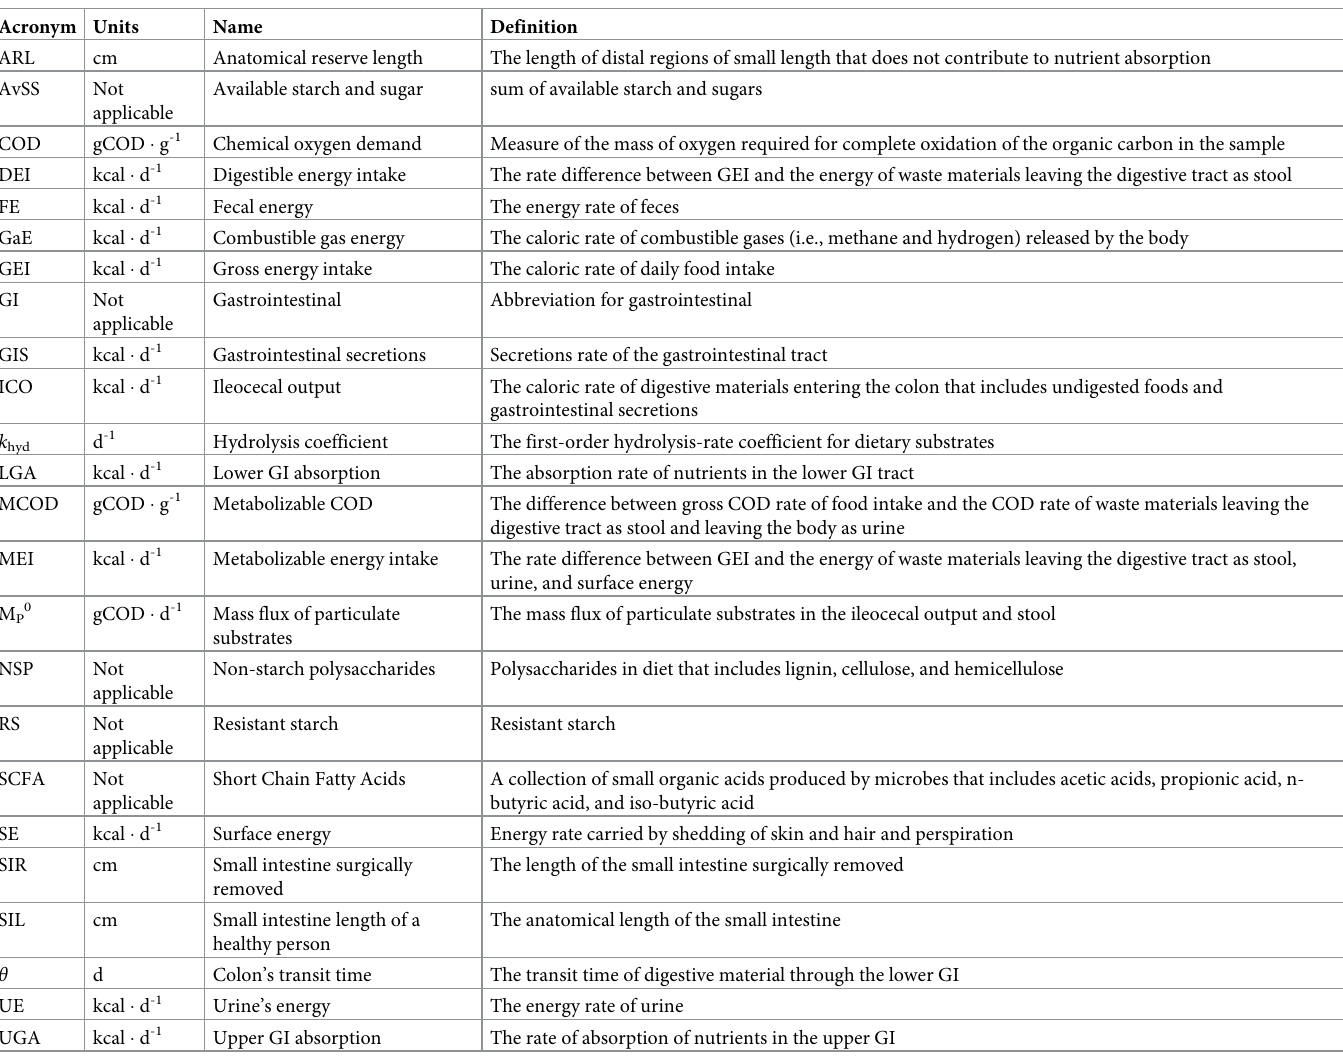
S1 Fig. Participant